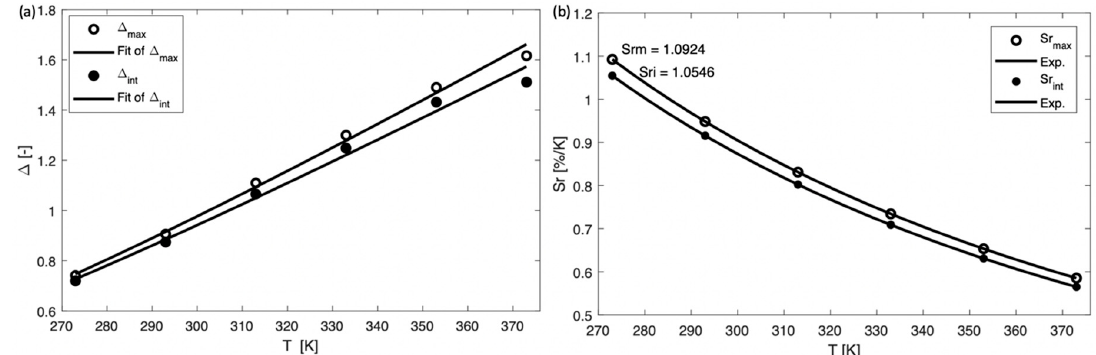
Figure 9. Plot presenting ( a ) the ∆ and ( b ) the relativity sensitivity (S r ) of α -MoO 3 : 1% Er 3+ , 10% Yb 3+ calculated at different temperatures.